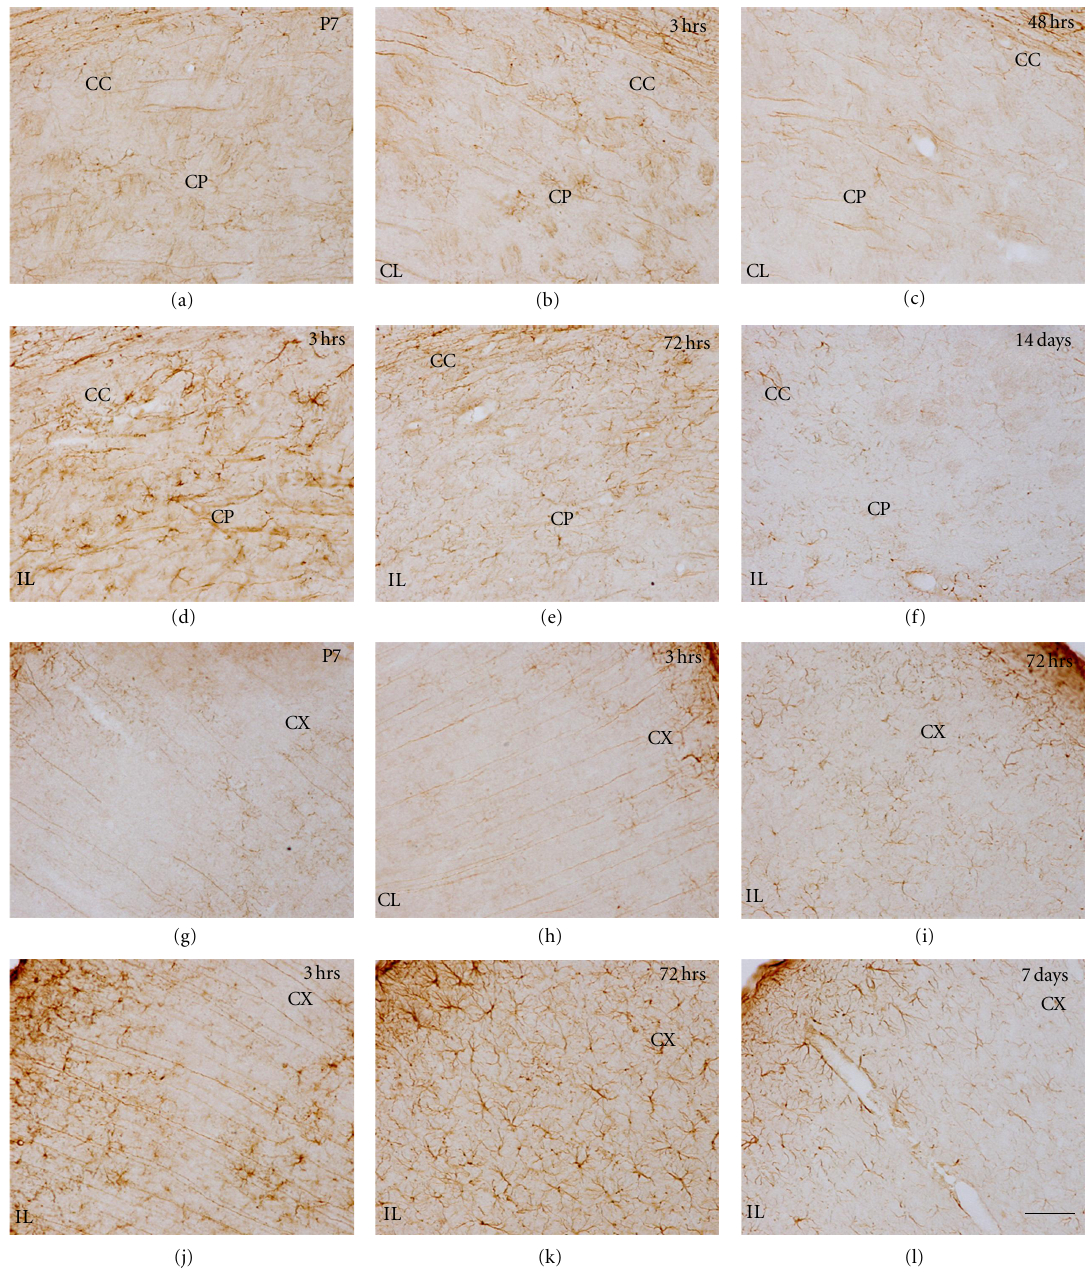
Figure 7: GFAP staining showing e ff ects of H/I on the caudate-putamen (a–f) and cortex (g–l) of the contralateral (CL) (b, c and h, i) and ipsilateral hemisphere (IL) from 3 hours (hrs) to 14 days after hypoxia (d–f and j–l). Reactive astrocytes are seen in ipsilateral side from 3–72hrs (d, e) as compared to the P7 control (a) or the contralateral side (b, c). At 14 days after hypoxia the astrocytes reactivity decreases (f). The cortex at 3 hrs (j) shows increase in reactive astrocytes and radial glia-like structures (only at this age) as compared to P7 control (g) and contralateral side (h) with a maximum reactivity at 72 hrs (k) when compared to the respective contralateral side (i); and a decrease in astroglial reactivity is seen at 7 days after hypoxia (l). Scale bar = 100 μ m. CP: caudate-putamen; CC: corpus callosum; cx: